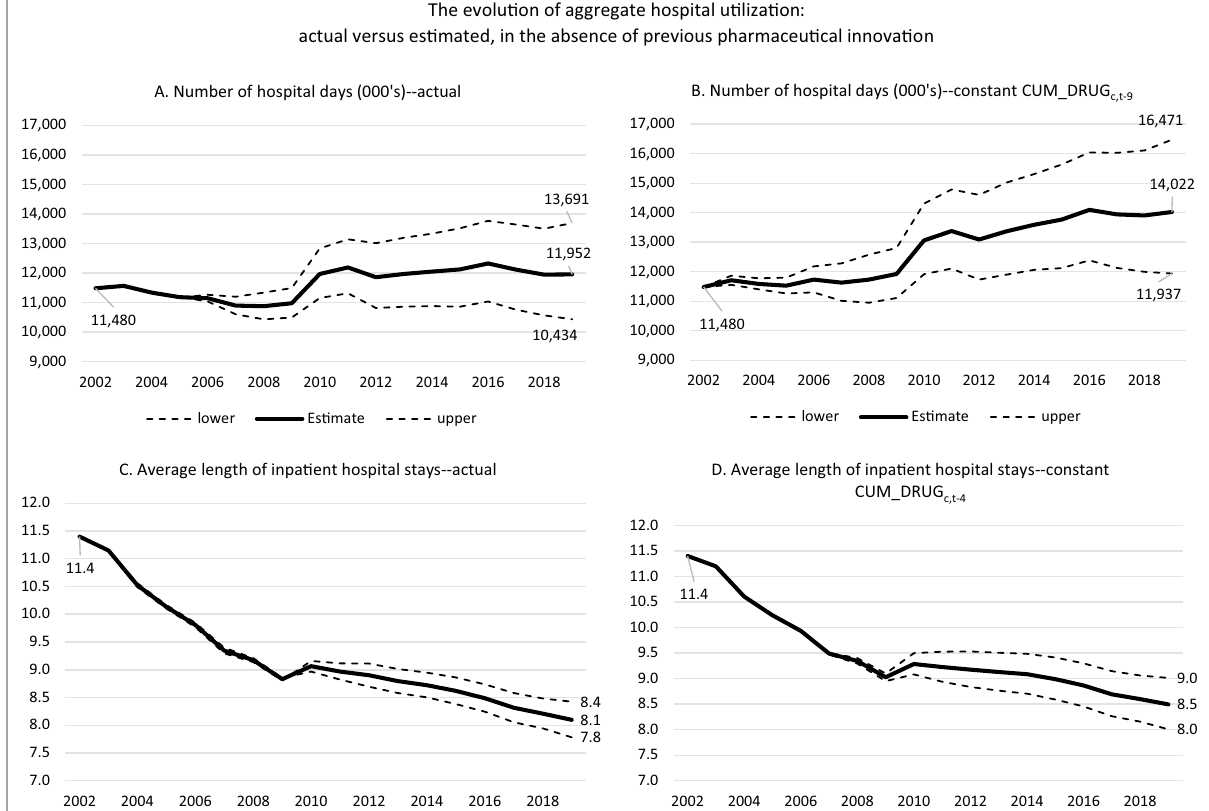
Fig. 6 The evolution of aggregate hospital utilization: actual versus estimated, in the absence of previous pharmaceutical